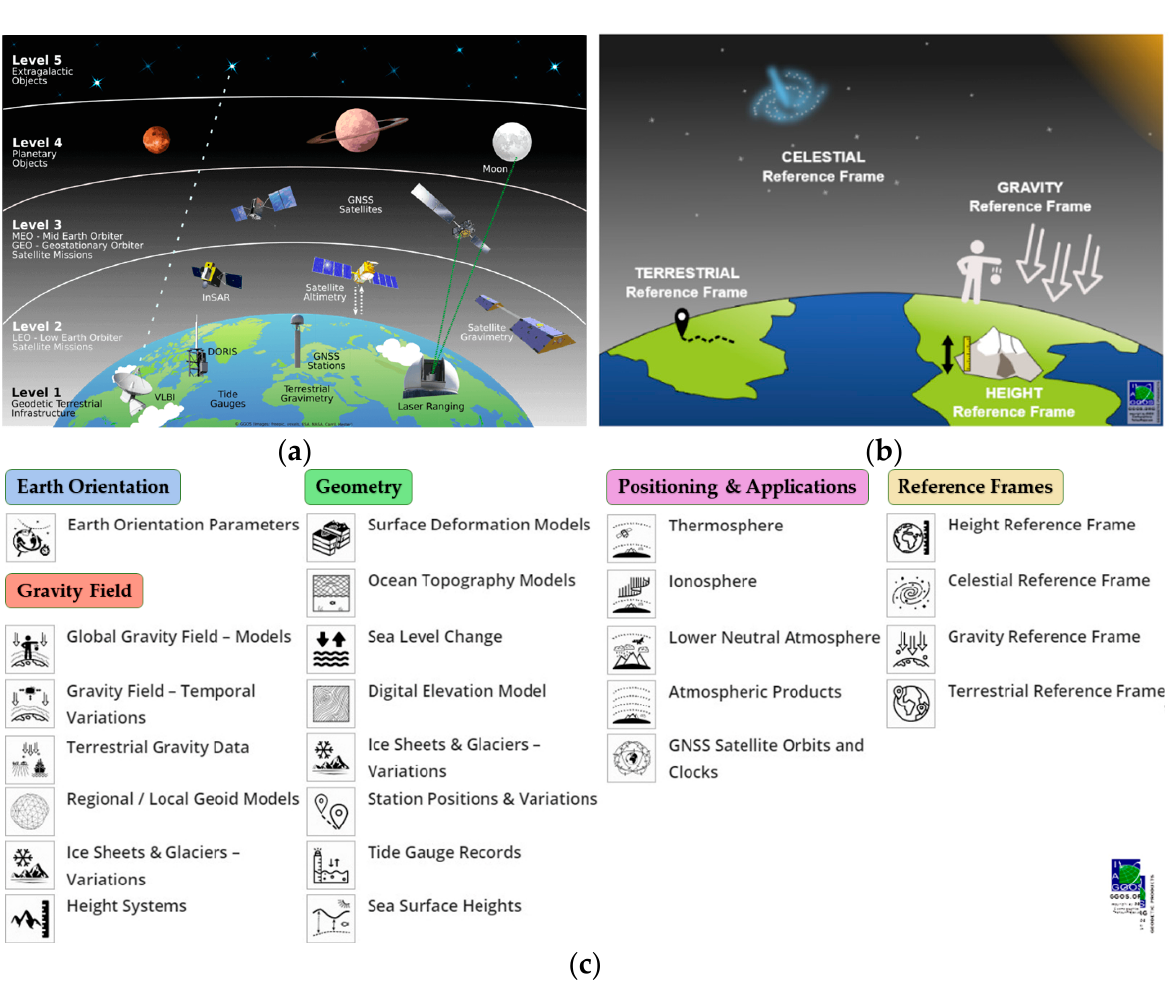
Figure 16. ( a ) Various levels of geodetic observations; ( b ) list of reference frames; ( c ) list of geodetic products; (source: GGOS website) [66].